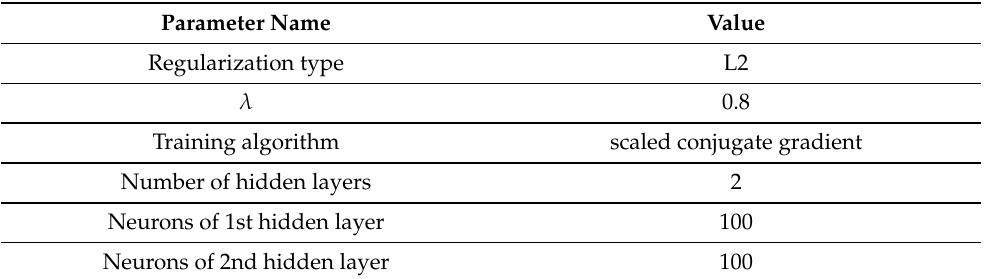
Figure 7. Structure of the Multi-Layer Perceptron Neural Network in the locally tunable scenario. Table 3. Multi-Layer Perceptron Neural Network